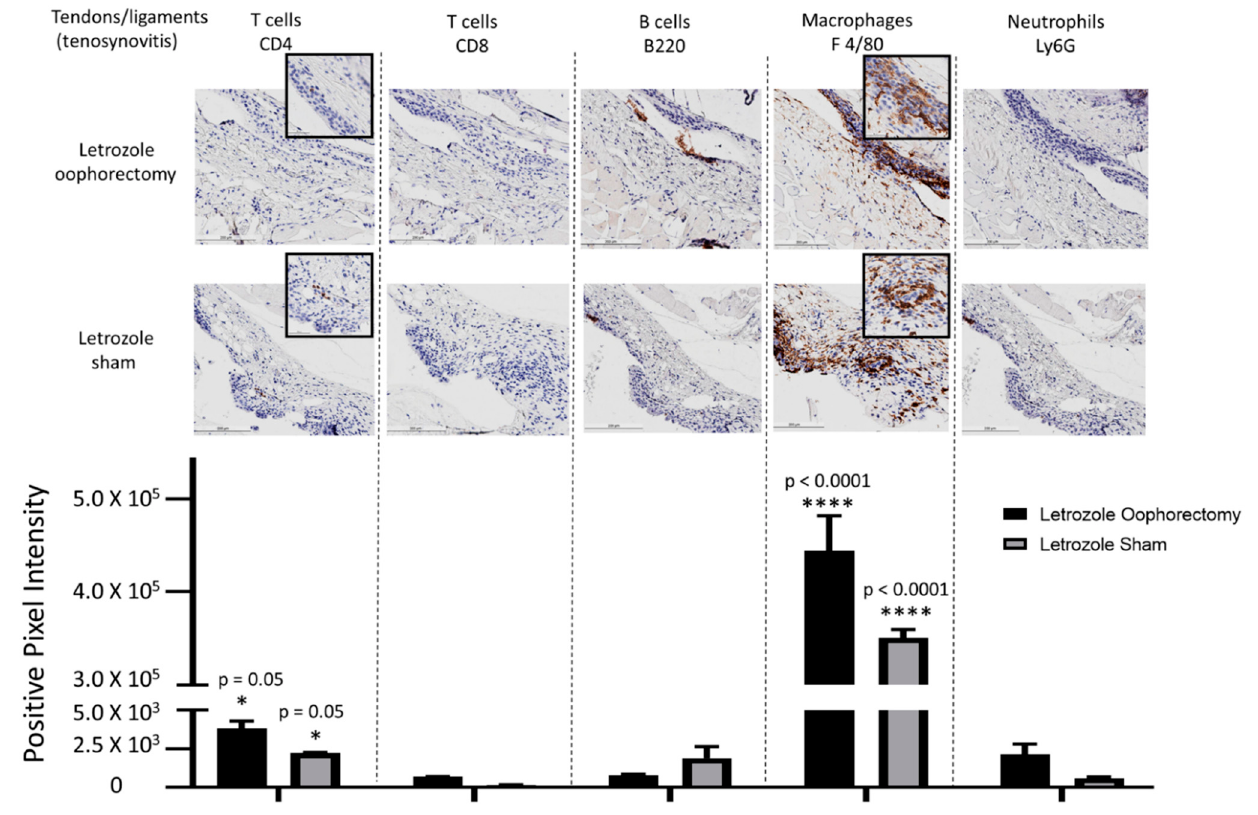
Figure 5. IHC for immune cell subtypes in tenosynovitis infiltrates shows a macrophage-mediated inflammatory response induced by aromatase inhibitor treatment. Following oophorectomy or control (sham) surgery and induction of AIIA with daily letrozole injections, mouse legs were collected and processed for histopathological assessment as described in the Materials and Methods Section. To evaluate immune cell subtypes in the tendons, IHC staining of CD4+ T cells, CD8+ T cells, B220+ B cells, F 4/80+ macrophages, and Ly6G+ neutrophils was performed. Data were analyzed via two-way ANOVA for group-wise comparisons relative to each IHC stain. Values are the mean ± SEM, with indicated p values determined following Tukey’s corrections for multiple comparisons to measure the statistical change between IHC cell stain/subtype. * p ≤ 0.05; **** p ≤ 0.0001. All values of p ≤ 0.05 were considered statistically significant compared to all other stains individually.